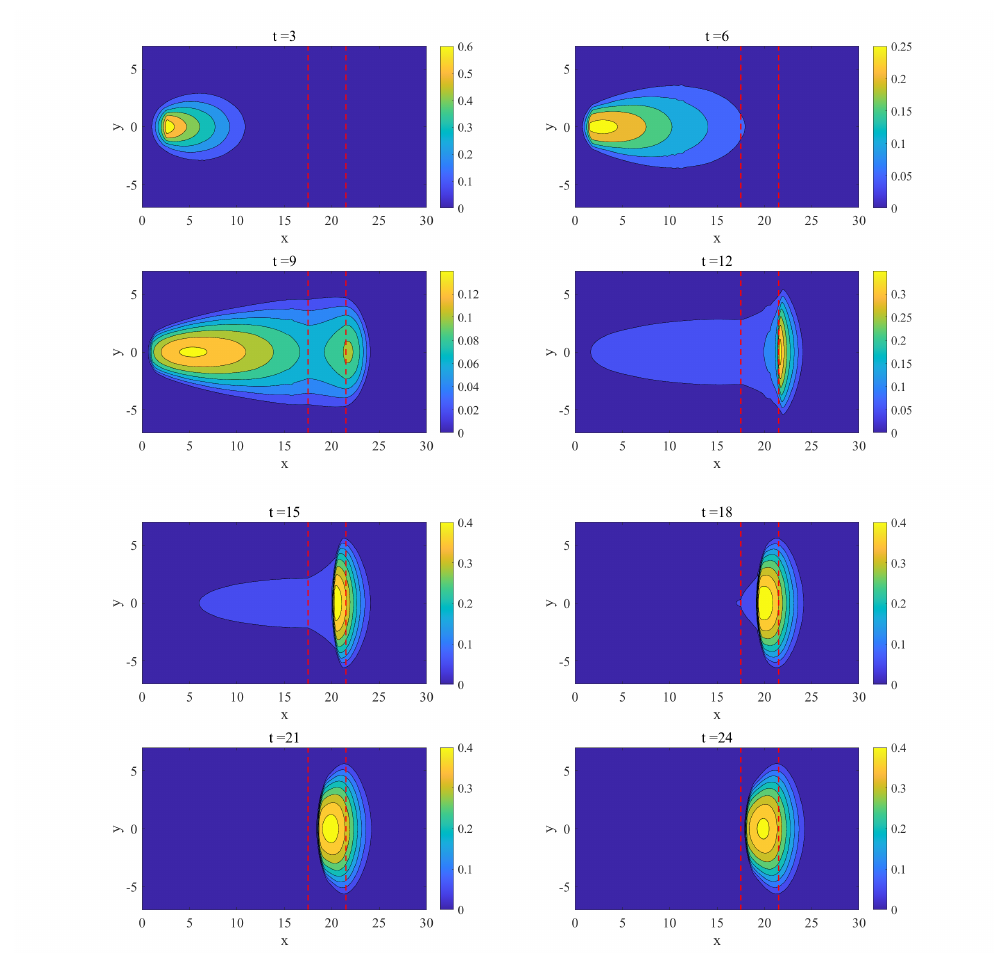
Figure 12. Thickness contours of the avalanche at t = 3,6,9,12,15,18,21,24 for the flow sliding down the inclined plane and merging continuously into a horizontal plane. The transition zone from the inclined plane to the horizontal plane lies between the two red dashed lines. The HLLC flux is